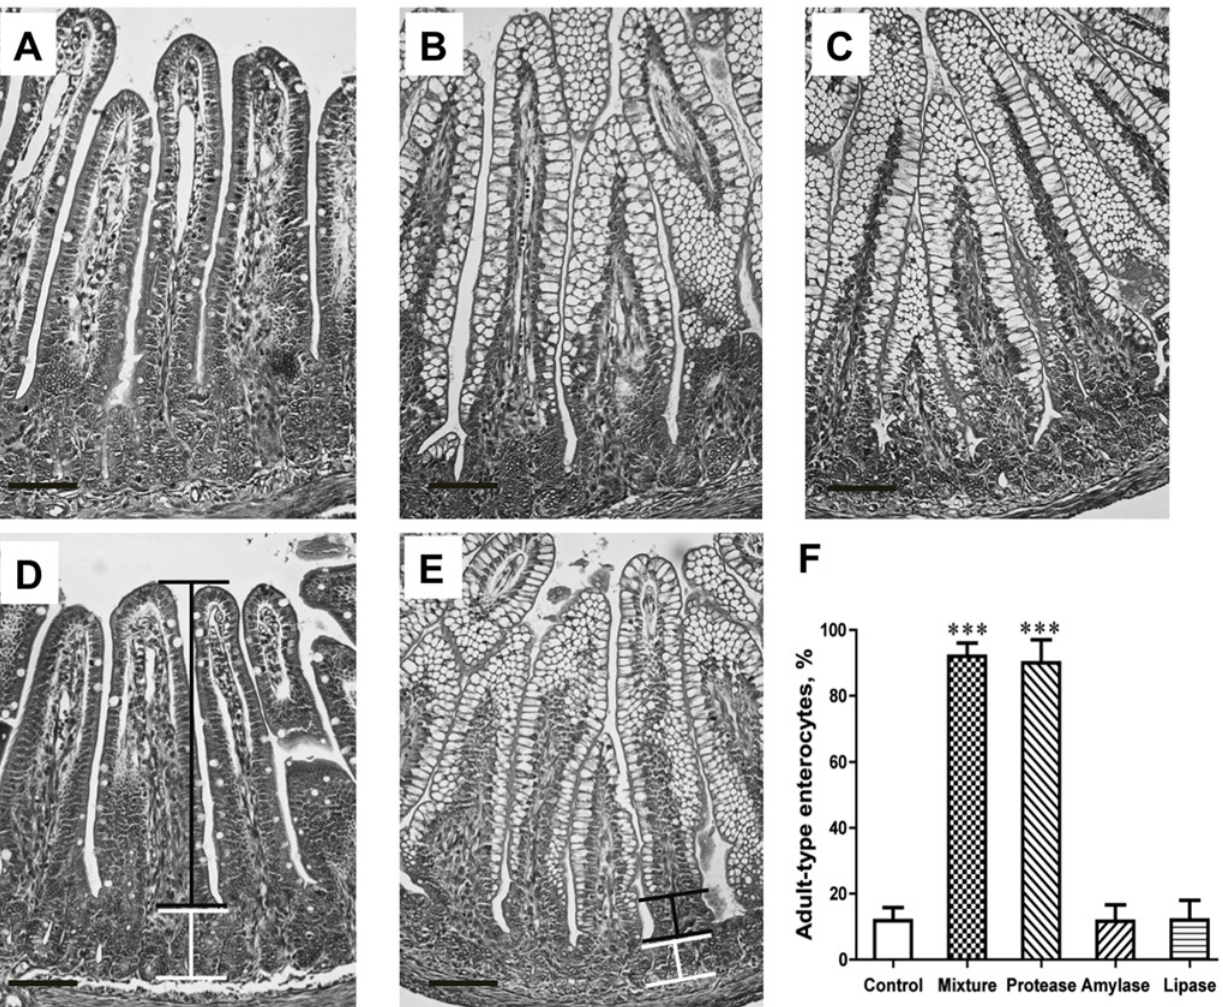
Fig 3. Photomicrographs of H&E stained distal small intestine sections from 17 d-old rats, showing the appearance of mature enterocytes, lacking supranuclear vacuoles, in the villi epithelium after gavage feeding with different microbial-derived enzymes, a protease (A), amylase (B), lipase (C), and a mixture thereof (D) or water (control, E) during 14 – 16 days of age in suckling rats. The morphometric evaluation of the epithelial maturity, i . e ., the portion of adult-type enterocytes, lacking supranuclear vacuoles, appearing on the villi is shown (F). The horizontal bar inserted indicates 100 μ m; black connector line shows the portion of villus with adult-type epithelium, and white line shows the crypt region. Statistically significant differences between control and enzyme-treated groups (mean ± SD, n = 7) are indicated by *** P < 0.001.